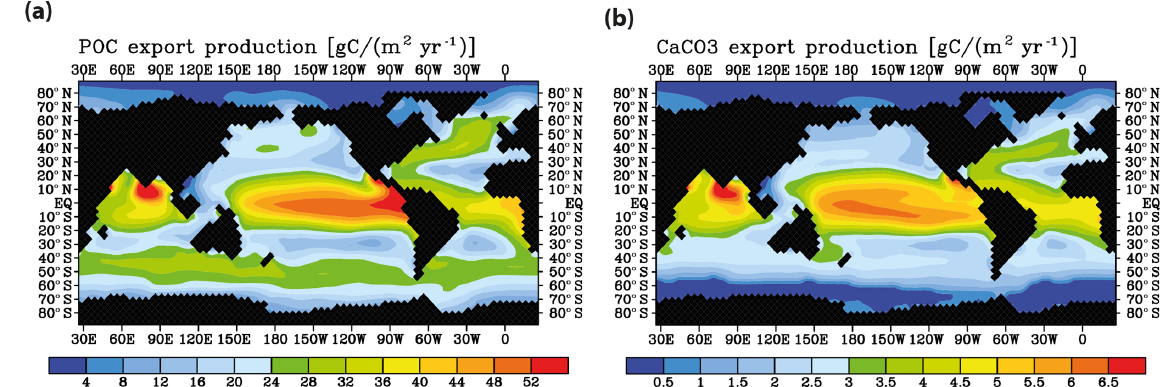
Figure 6. Model control run results for (a) biological export production of particulate organic carbon and (b) CaCO 3